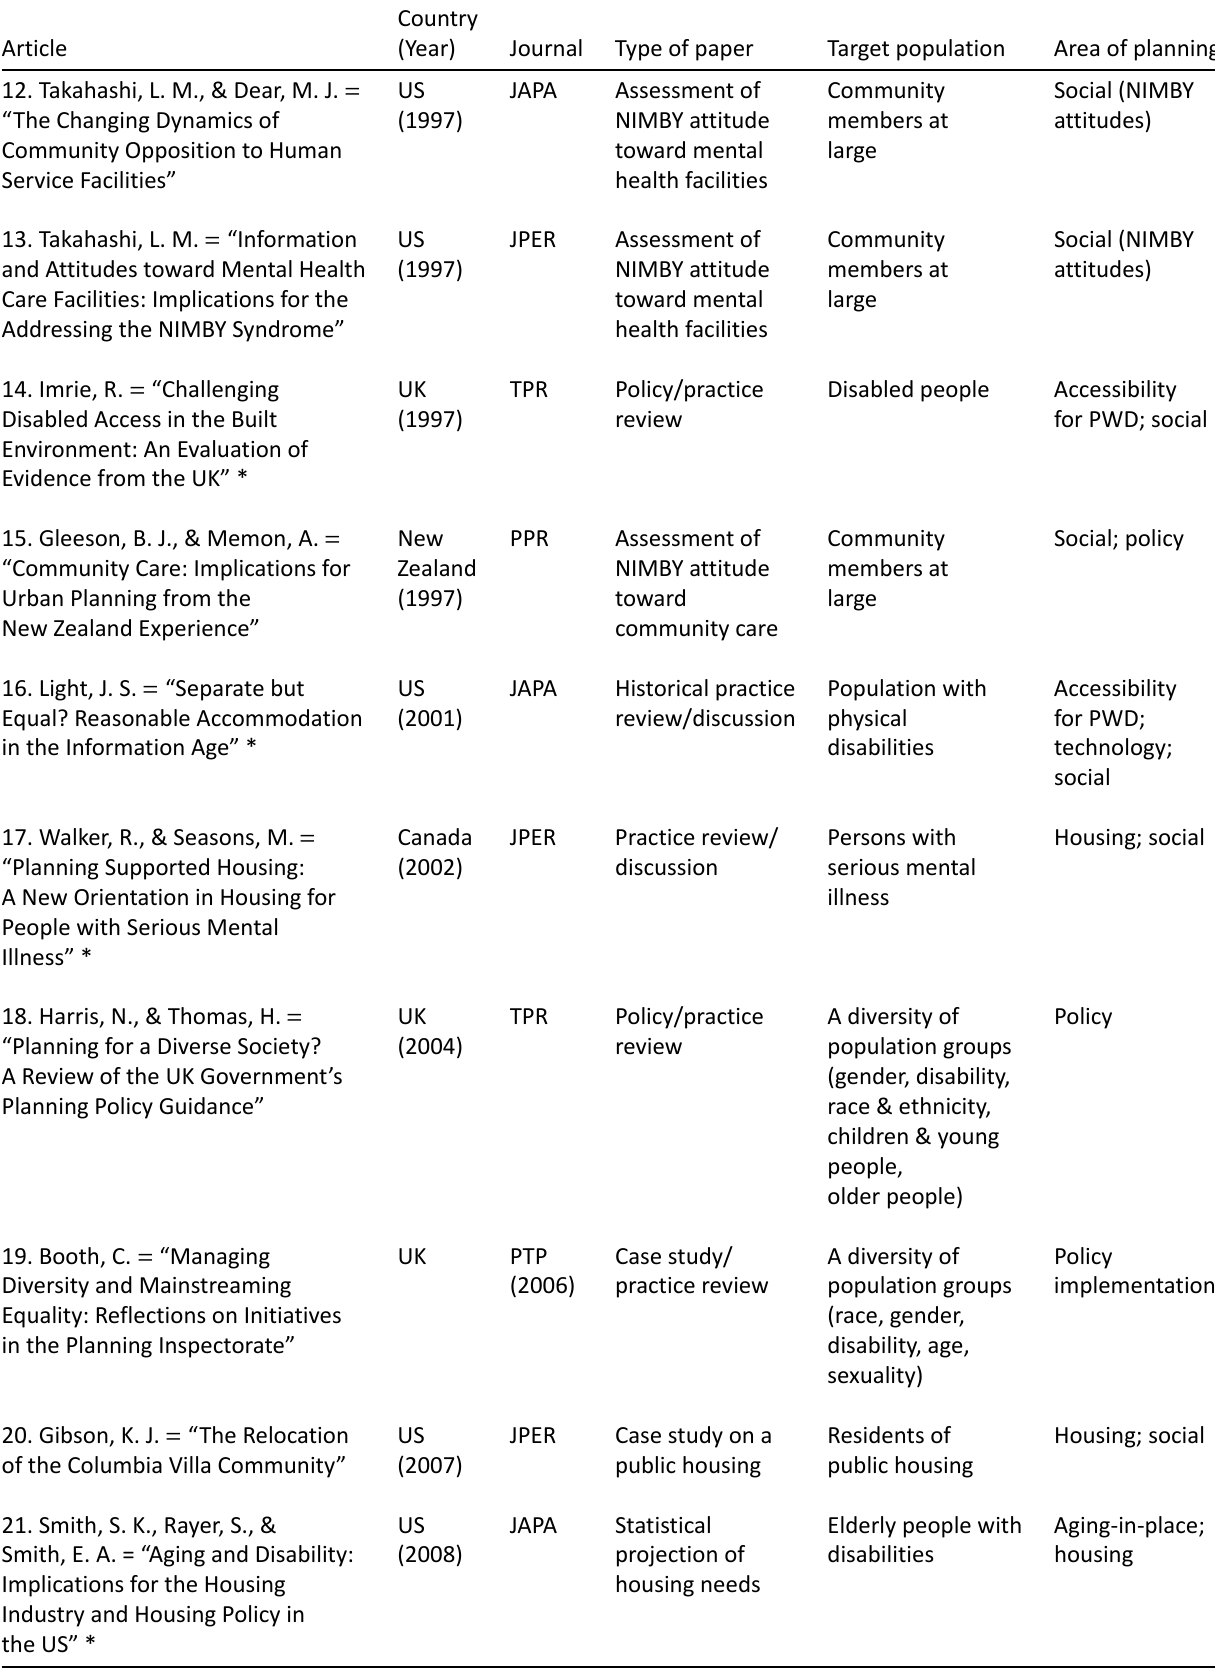
Table 3. (Cont.) Summary of reviewed